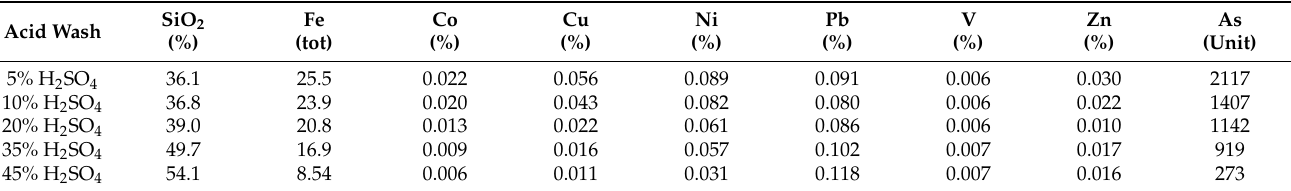
Table 8. Chemical analysis of the washed acid digestion residue.